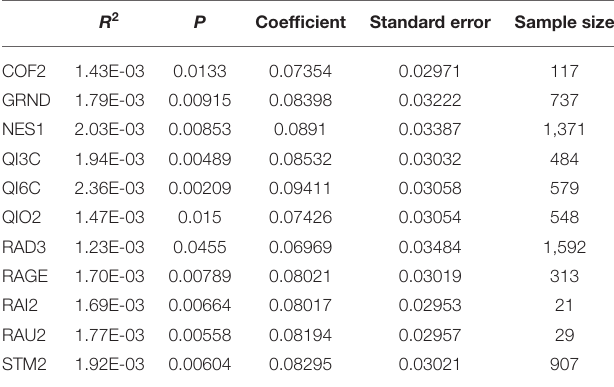
TABLE 3 | Leave-one-out analysis results. R